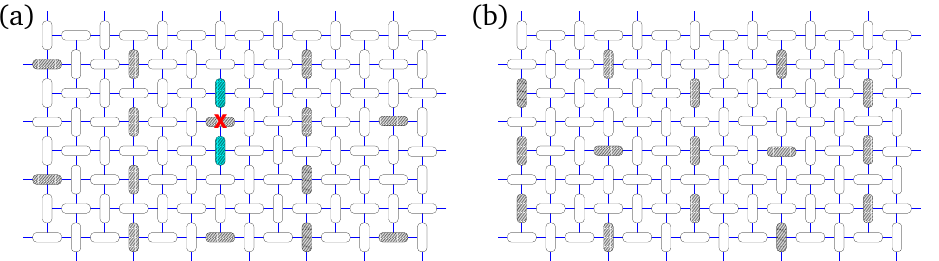
Figure 18: Intermediate phases between the 1 / 8- and 1 / 6- plateaux (left panel), and an example of the 2 / 15-plateau configuration (right